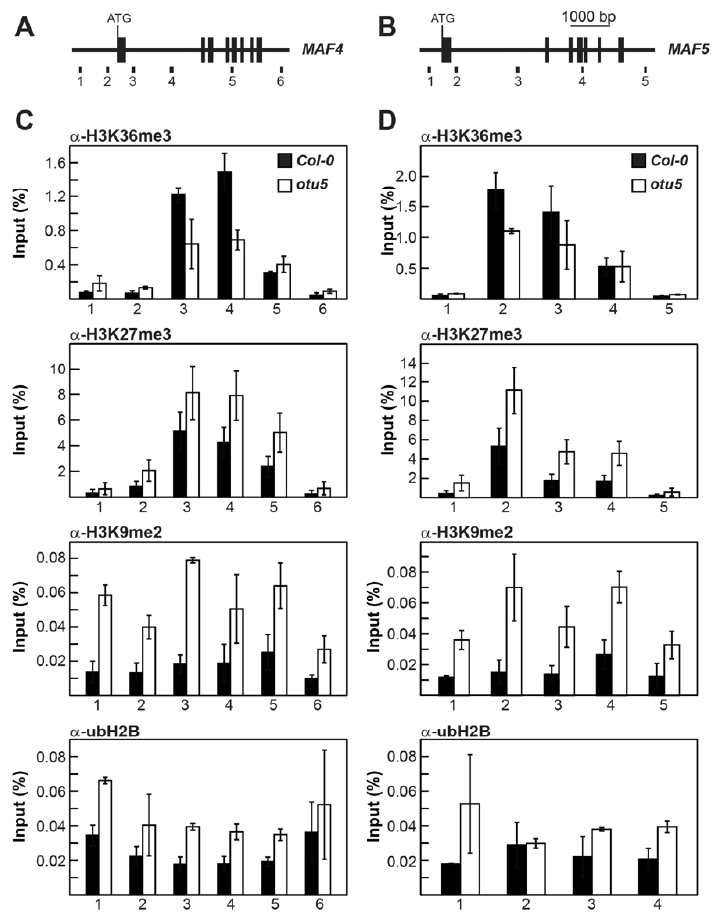
Figure 5. MAF4 - and MAF5 -associated levels of major activating and repressive histone marks in otu5-1 plants. ( A , B ) Schematic diagrams in scale showing the MAF4 ( A ) and MAF5 ( B ) gene structures depicting six and five amplification regions (bars), respectively, labeled 1-6 or 1-5, which were analyzed by qChIP. The gene structures of MAF4 and MAF5 are depicted for FLC in Figure 4. The corresponding primer pairs are listed in Table S4. ( C , D ) The percentage qChIP amplification yields, in comparison with that amplified from input DNA, from six MAF4 ( C ) or four to five MAF5 ( D ) regions using various antibodies, as indicated against H3K36me3, H3K27me3, H3K9me2, and ubH2B in otu5-1 and Col-0 seedlings. Error bars indicate standard deviations.